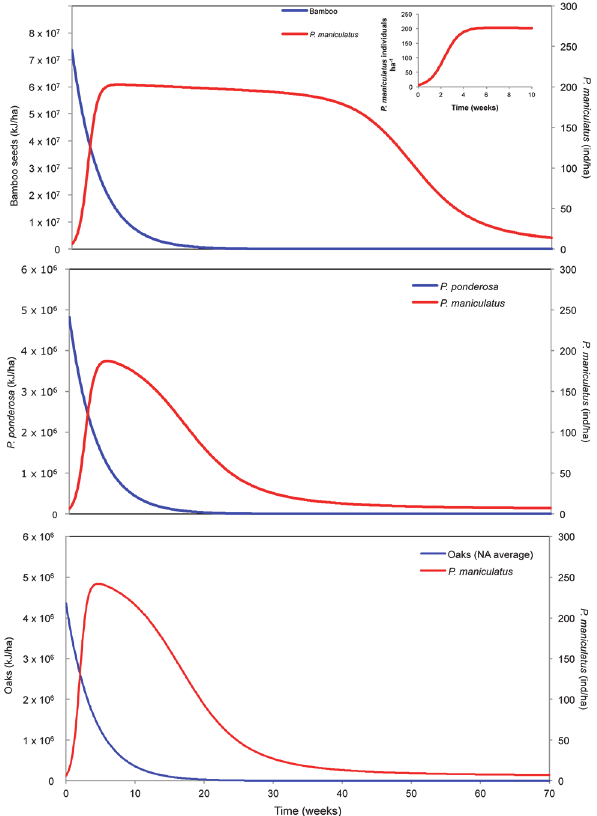
Fig 3. Joint dynamics of seeds ([a] bamboo, [b] oak and [c] pine) and deer mice densities following a mast event. Deer mice densities (dashed line) rise sharply in response to newly available seeds (solid line) to a new plateau several times higher than M 0 , their initial abundance. As mice consume seeds, they are initially only limited by their maximum rate of consumption (i.e. handling time [ h ]), not by supply, producing a prolonged quasi-equilibrium (QE). QE lasts until seed density falls below the immigration threshold and then again when deer mice become seed-limited again; seeds are depleted completely and the deer mice population returns to its pre-mast density. The QE period for bamboo lasts much longer than the other two native species and reaches a higher peak value than either oaks or pines. Parameter values for this figure are listed in Table 1 with derivations in S2